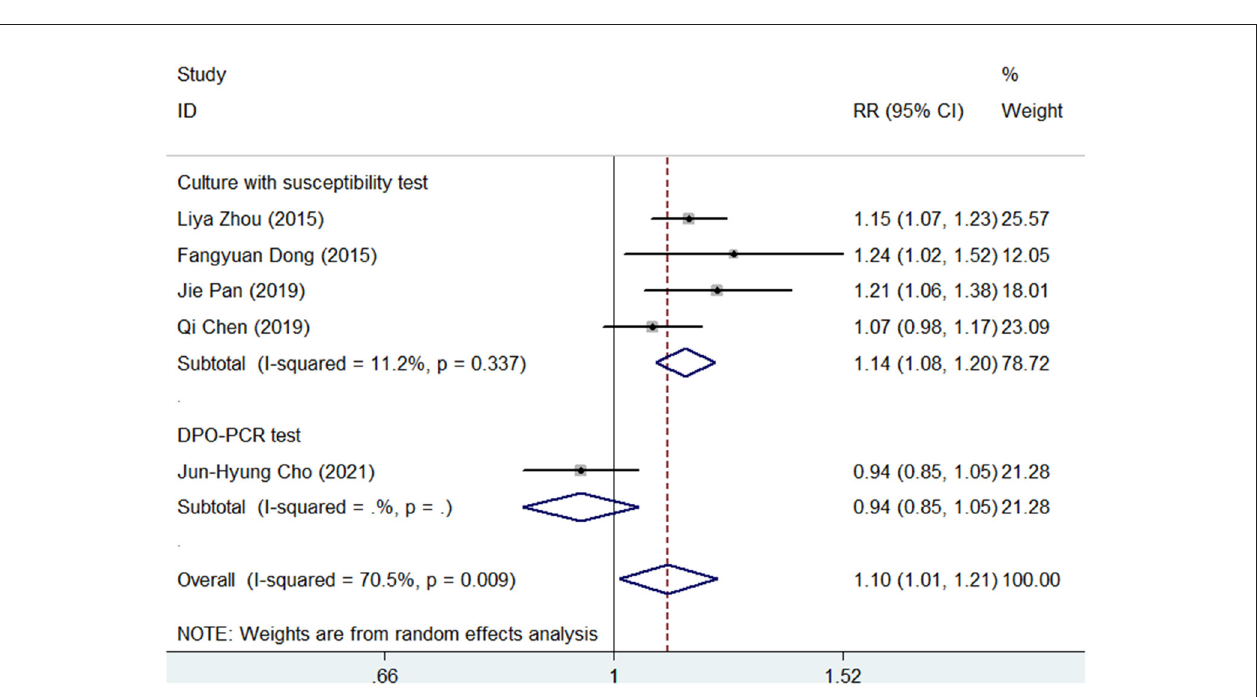
mainly because of increased antibiotic use in the community (7, 24). Rational first-line regimens with a high efficacy should be applied to eradicate H. pylori to avoid secondary antibiotic resistance and failures of second- or third-line treatment,